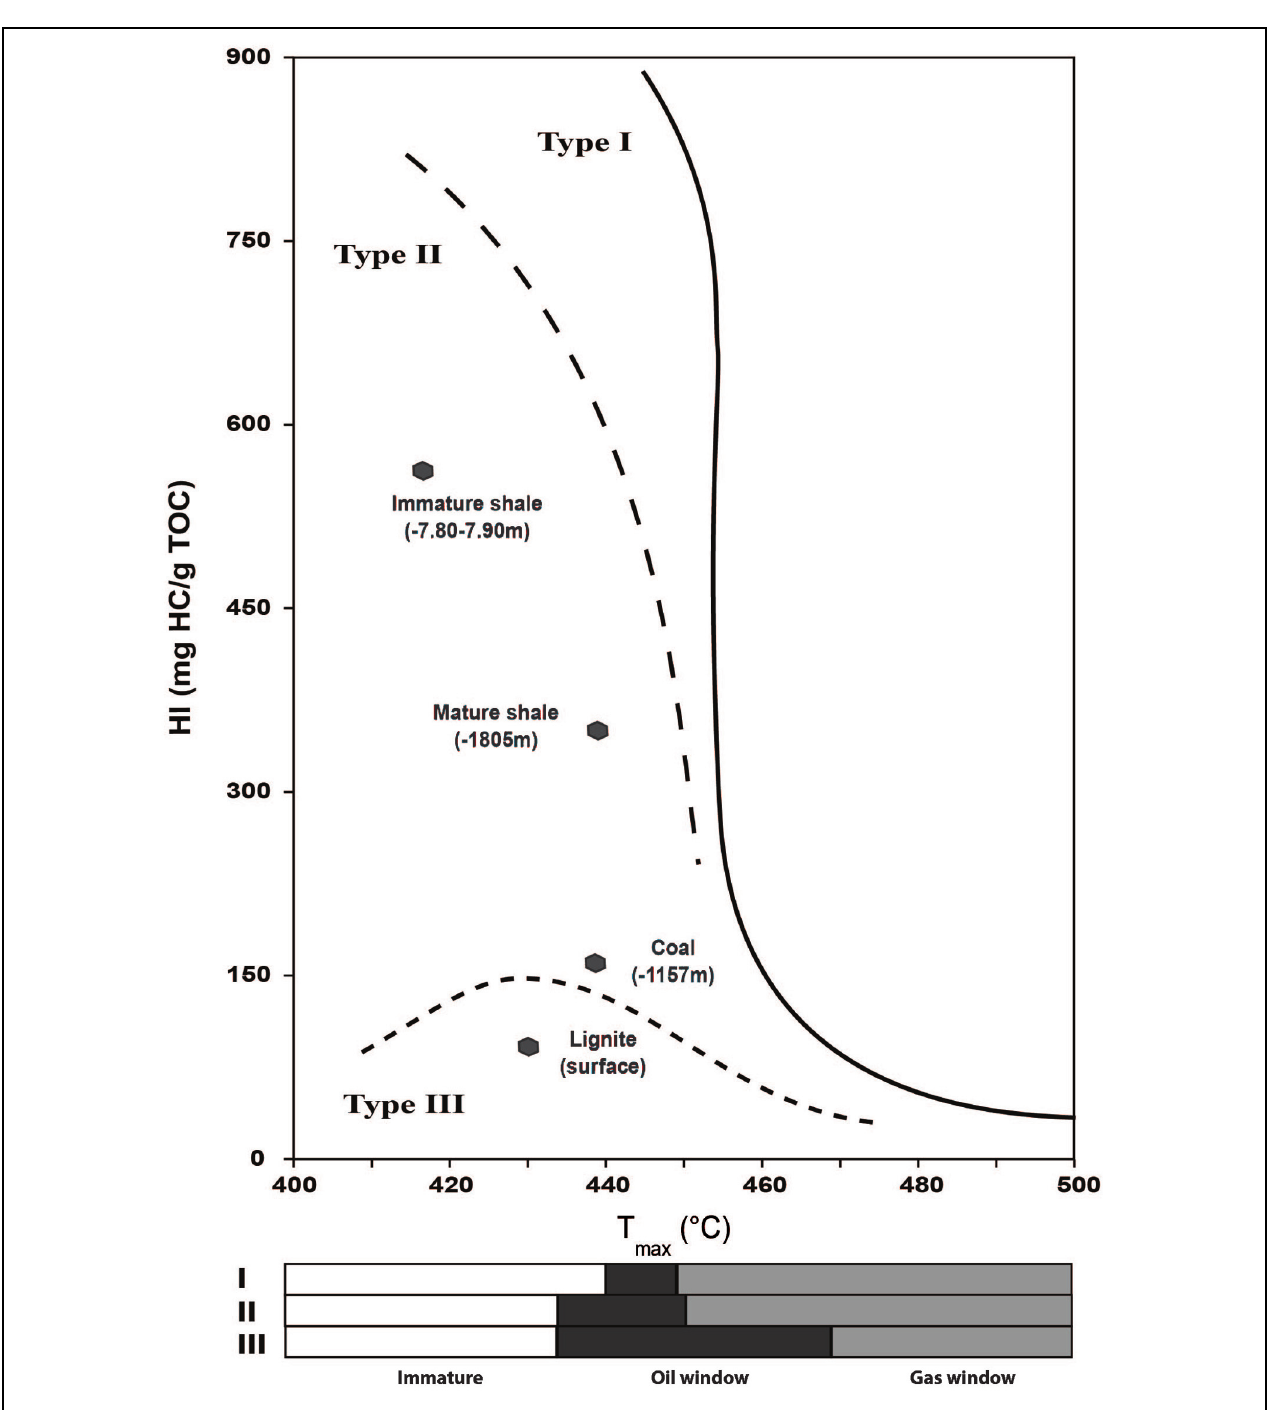
FIGURE 1 | HI and T max crossed-diagram of the bulk rock (BR) samples analyzed by Rock-Eval 6